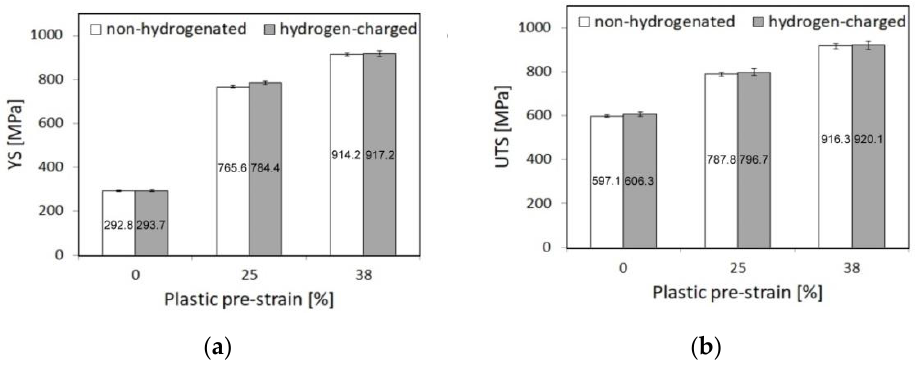
Figure 8. The effects of plastic pre-straining and subsequent electrochemical hydrogen charging of 316H steel on its strength properties: ( a ) yield stress; ( b ) ultimate tensile strength.